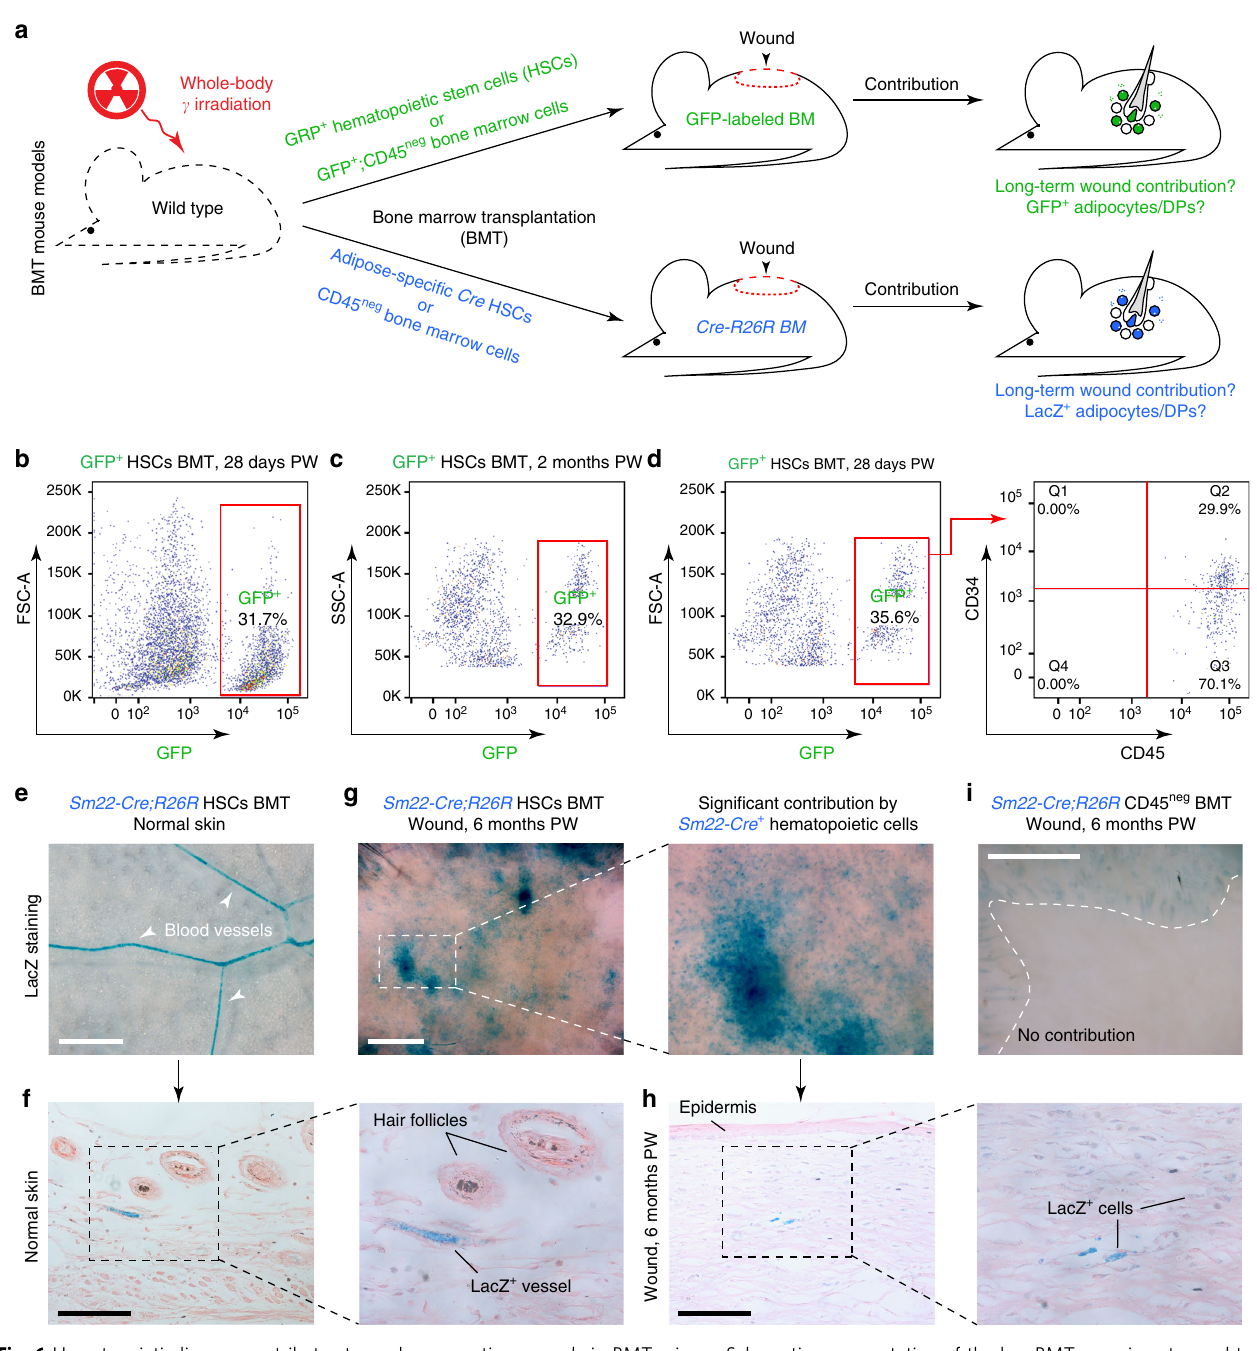
Fig. 6 Hematopoietic lineage contributes toward regenerating wounds in BMT mice. a Schematic representation of the key BMT experiments used to assess the contribution of hematopoietic lineage cells to de novo adipocytes. b – d Based on fl ow cytometry analysis, the hematopoietic lineage contributes ~30% of the cells in dermal wound tissue 28 days and 2 months PW in GFP + HSCs BMT mice. e – h LacZ expression patterns in the wounds of Sm22-Cre; R26R HSCs BMT mice con fi rmed that a portion of contractile wound cells ( g , h ) and perivascular contractile cells (arrowheads on e ) originate from the hematopoietic lineage. i Wounding experiments in Sm22-Cre;R26R CD45 neg BMT mice showed that non-hematopoietic BM cells do not contribute toward contractile wound and peri-wound cells. Images shown in e – i are representative of the lacZ expression patterns observed in three or more independent samples. HSC: hematopoietic stem cell, BM: bone marrow, BMT: bone marrow transplantation, DP: dermal papilla, PW: post-wounding day. Size bars: e , g , i — 1 mm; f , h — 125 µ